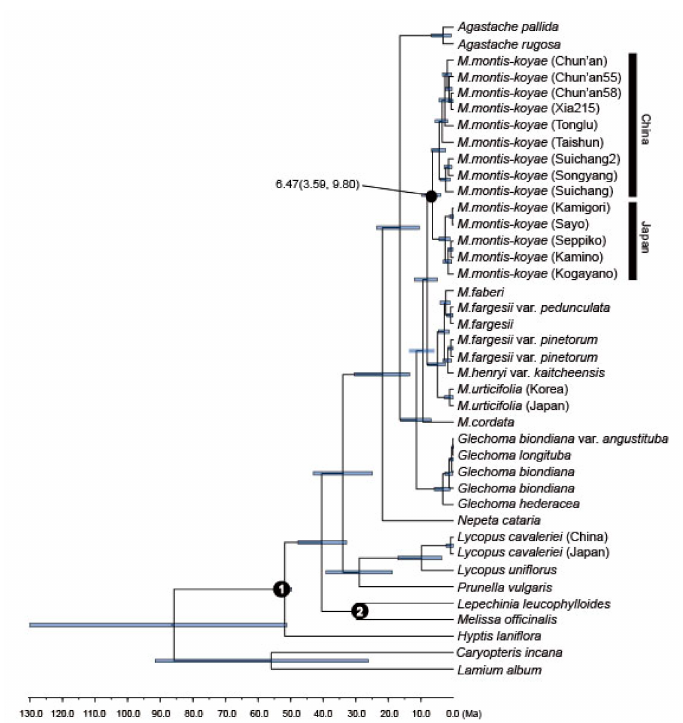
Figure 5. Results of the BEAST analysis based on combined nuclear (ITS and ETS) data. Gray bars represent the 95% highest posterior density intervals for node ages. Fossil calibrations are marked with numerals 1 and